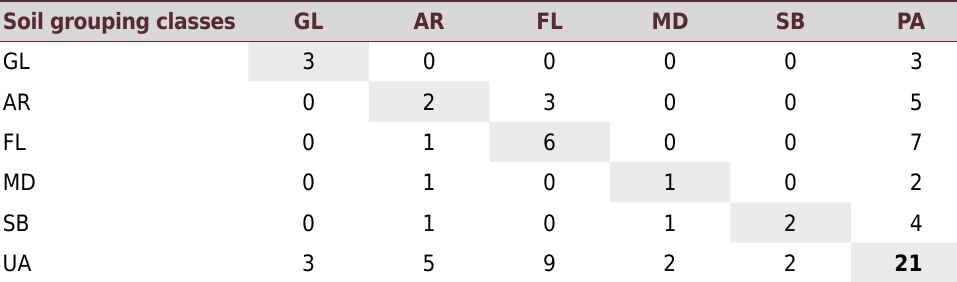
Table 5. Confusion matrix of data set 2 (field samples) Soil grouping